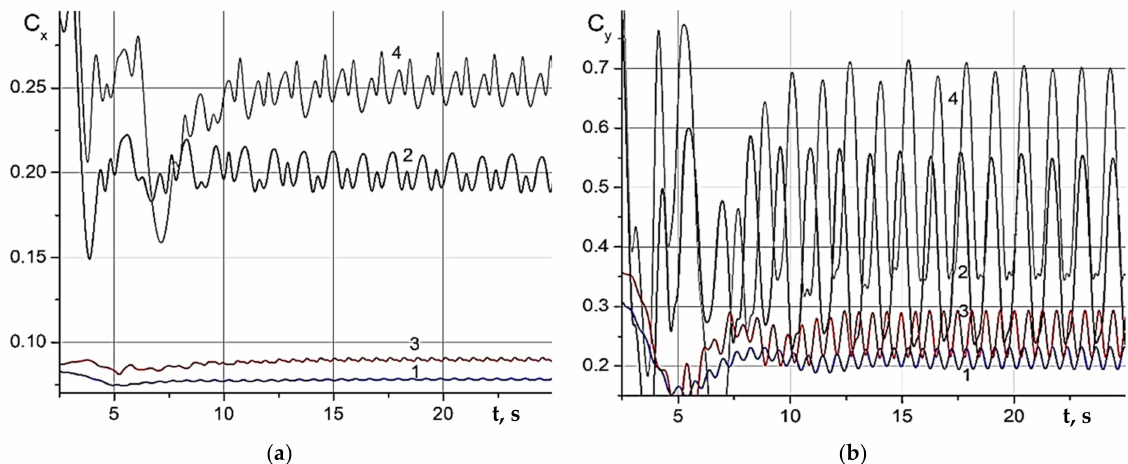
Figure 15. Integral values of drag ( a ) and lift coefficients ( b ) on a tilted plate L = 2.5 cm in strongly stratified and potentially homogeneous fluids as functions of time: curve ( 1 ) N = 0.83 s − 1 , U = 4.3 cm/s, α = 6 ◦ , ( 2 ) N = 0.83 s − 1 , U = 3.6 cm/s, α = 16 ◦ ; ( 3 ) N = 10 − 5 s − 1 , U = 4.3 cm/s, α = 6 ◦ ; ( 4 ) N = 10 − 5 s − 1 , U = 3.6 cm/s, α = 16 ◦